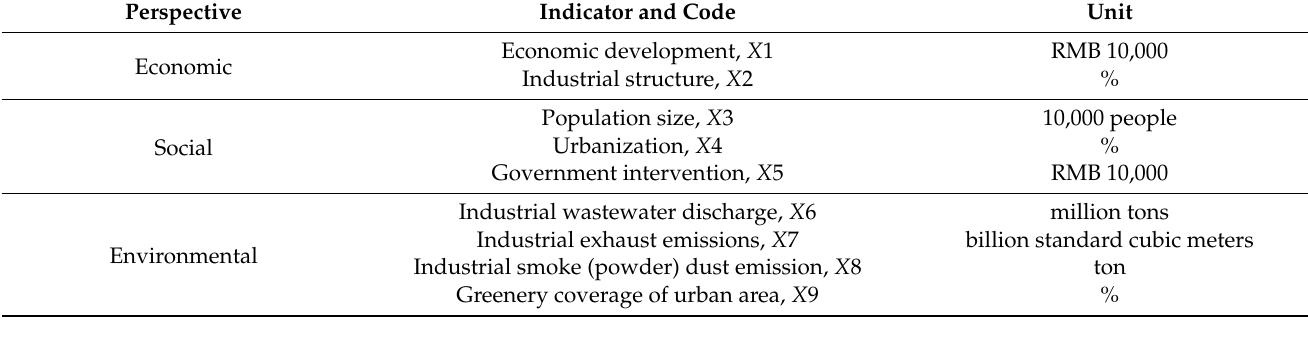
Table 3. Socioeconomic and environmental indicators of the CUA.